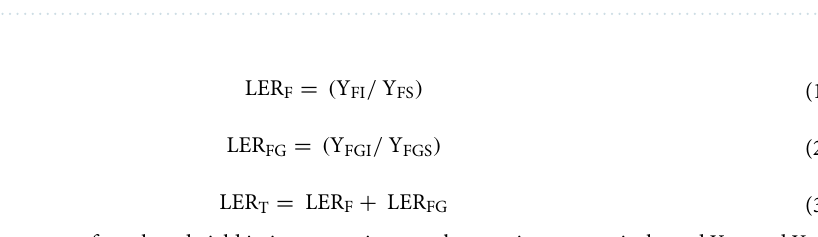
Table 2. Analysis of variance for the effect of cropping pattern and fertilization on evaluated traits in fennel. NS, *, and ** indicate non-significant differences and significant differences at the 5% and 1% probability levels,